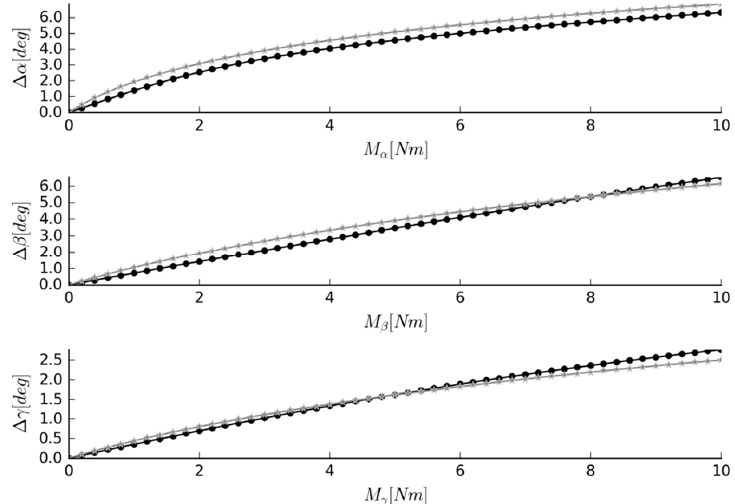
Figure 5. The obtained mechanism with the L4 and the L5 vertebrae for reference: ( a ) Sagittal-plane view; ( b ) Transverse-plane view.